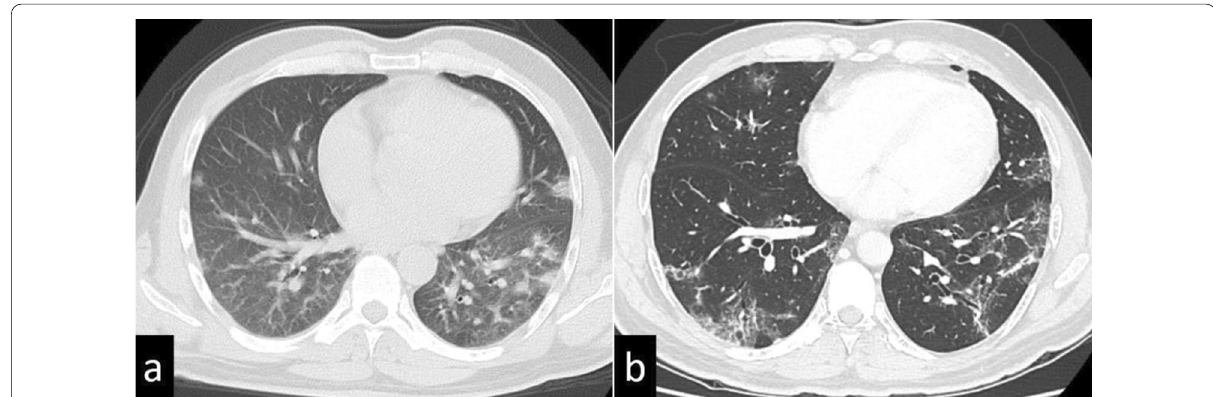
Fig. 6 Findings of case 3 with chest computed tomography. a Ground-glass opacities and faint shadows were identified in bilateral lower lobes immediately after COVID-19 infection. b The opacities and shadows had regressed 19 days before the operation